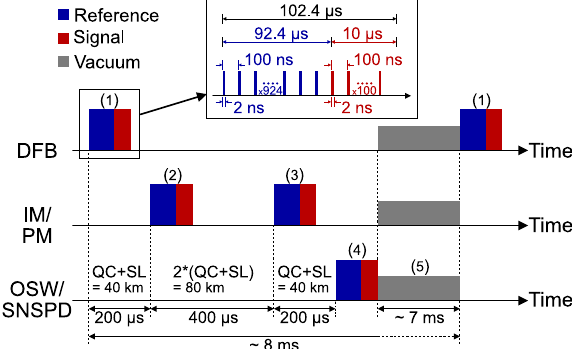
Fig. 6 Timing diagram of active devices. (1) At 0 s, Charlie generates an optical pulse train using the DFB laser and divides the pulse train into clockwise and counterclockwise trains. Then, he sends them to Alice and Bob. (2) After 200 µs, Alice (Bob) receives the clockwise (counterclockwise) train from Charlie and just sends it back using IMs operating at the peak bias point. (3) After 400 µs, Alice (Bob) receives the counterclockwise (clockwise) train from Bob (Alice) and sends it back with random encoding using the IMs and PM. (4) After 200 µs, Charlie measures the incoming trains from Alice and Bob using OSWs and SNSPDs. (5) Lastly, data communication between FPGA and PC is performed for approximately 7 ms. The transmission distances (delays) for sections (1)-(2), (2)-(3), and (3)-(4) are 40 km (200 µs), 80 km (400 µs), and 40 km (200 µs), respectively. The inset shows the sequence of the pulse train. It consists of 924 reference pulses followed by 100 signal pulses. Each pulse is sent at 10 MHz with a pulse width of 2 ns (FWHM). Thus, the activated duration of the train is 102.4 µs. The abbreviation de fi nitions are as follows. DFB distributed feedback, OSW optical switch, SL 15-km storage line, QC 25-km quantum channel, IM intensity modulator, PM phase modulator, SNSPD superconducting nano-wire single- photon detector.